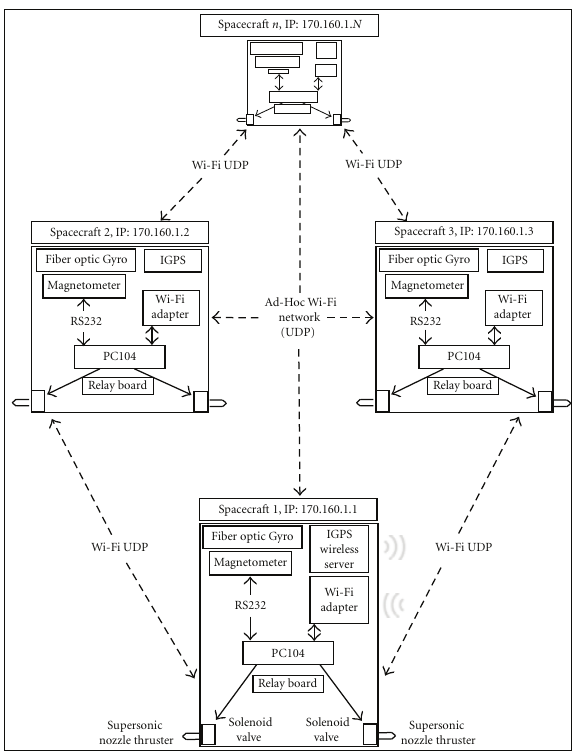
Figure 5: Ad-hoc wireless network at the SRL test-bed.